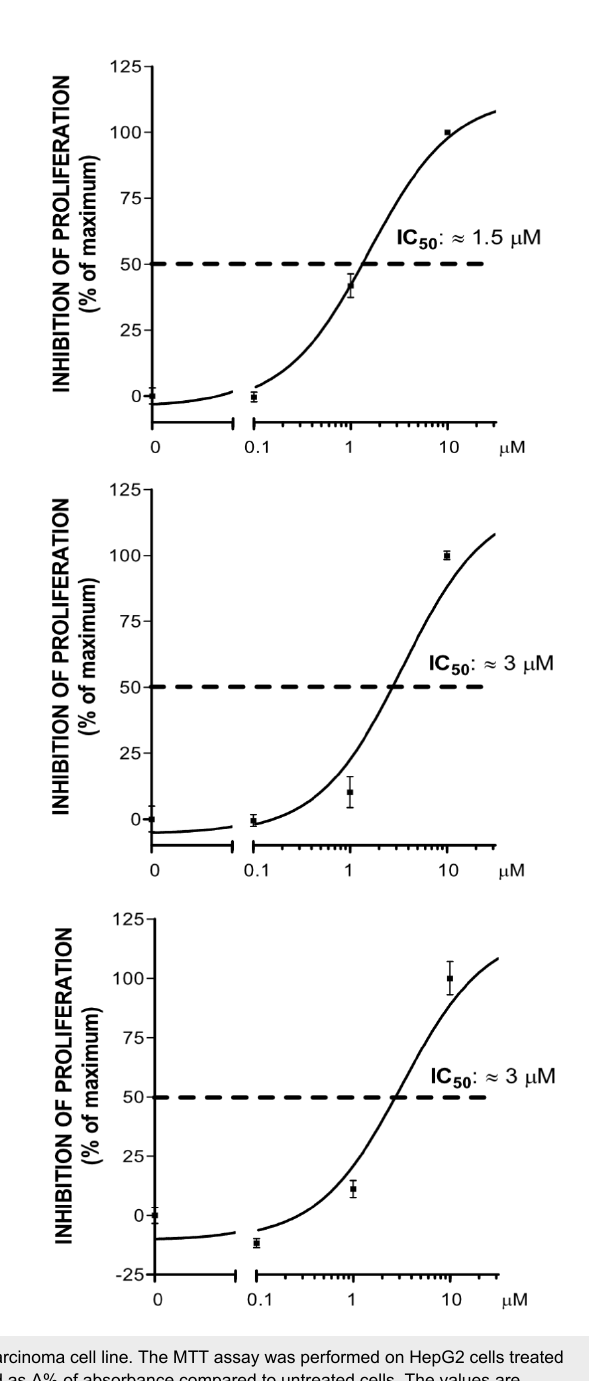
Kupchan’s partitioning procedure as described in [26]. The CHCl 3 extract (4.76 g) was chromatographed with a silica gel MPLC by using a solvent gradient system from CH 2 Cl 2 to CH 2 Cl 2 /MeOH 8:2. The fractions eluted with CH 2 Cl 2 /MeOH 97:3 (853.3 mg) were further purified by silica gel column chro-